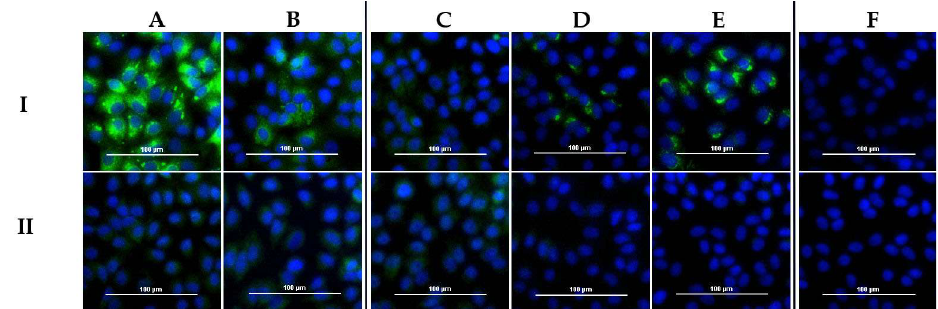
Figure 5. DUGV IFA: Cells infected with DUGV ( I ), as well as non-infected control wells ( II ), are depicted. Sera A and B represent DUGV seropositive samples, with serum A being higher seropositive than serum B. Sera C, D and E yielded CCHFV antibodies only. Whereas serum C is an example of a true-negative serum, sera D and E show specific staining of DUGV-infected cells. Serum F (CCHFV-/DUGV-) served as a negative control.